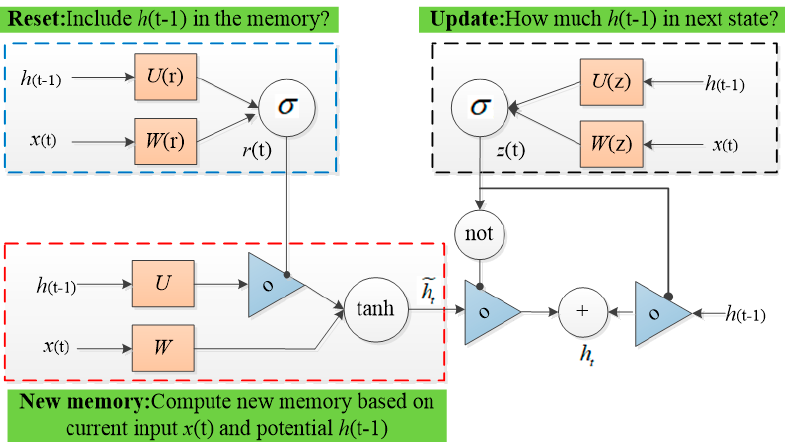
Figure 1. The model training structure of the GRU network.